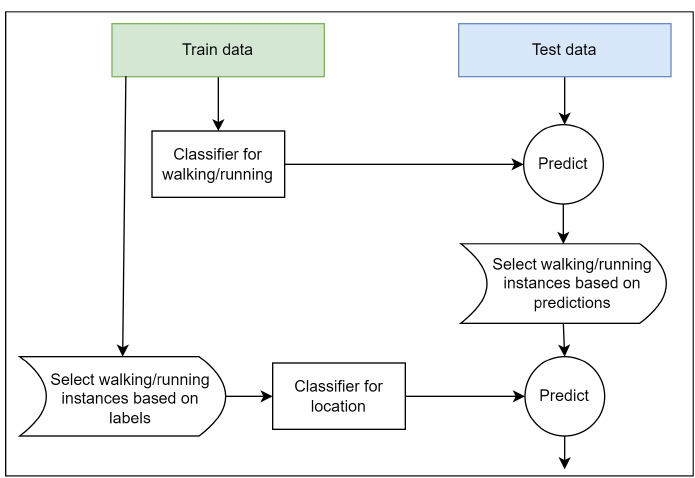
Figure 1. Pipeline for recognizing the unknown phone location of the Test